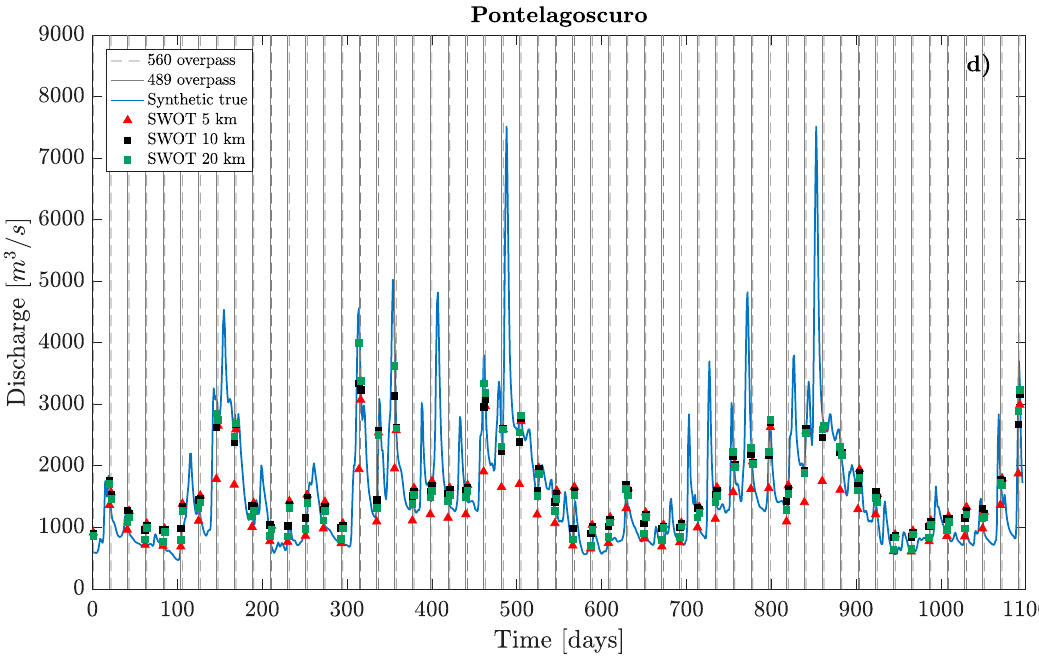
Figure 8. Flow hydrograph sampling of the satellite at the four gauging stations considering all possible orbits and different river discretization lengths.